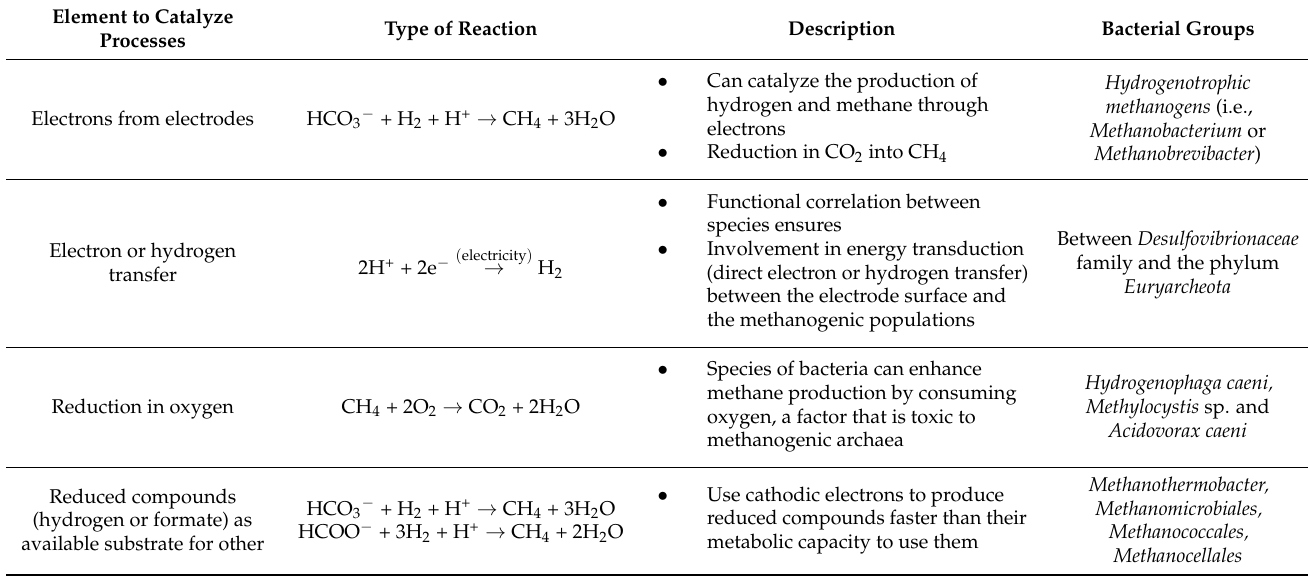
Table 2. Production of the components required in biocathode processes